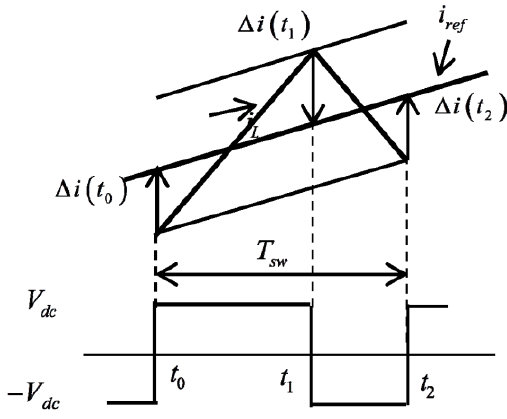
Figure 4. Conventional adaptive hysteresis current control.